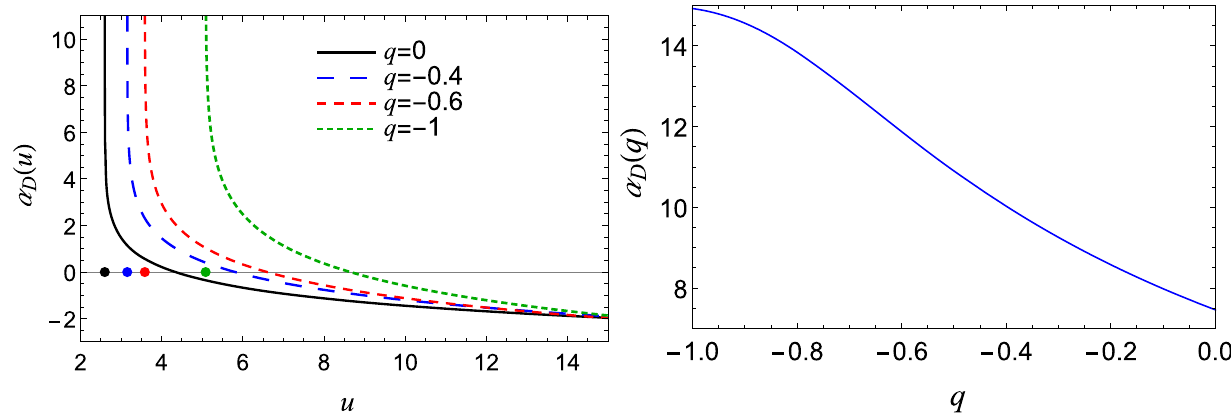
Fig. 6 a (Left)TheVariationofdeflectionangleasafunctionofimpact parameter u for different values of the parameter q . Points on the hor- izontal axis represent the values of the impact parameter u = u ps at